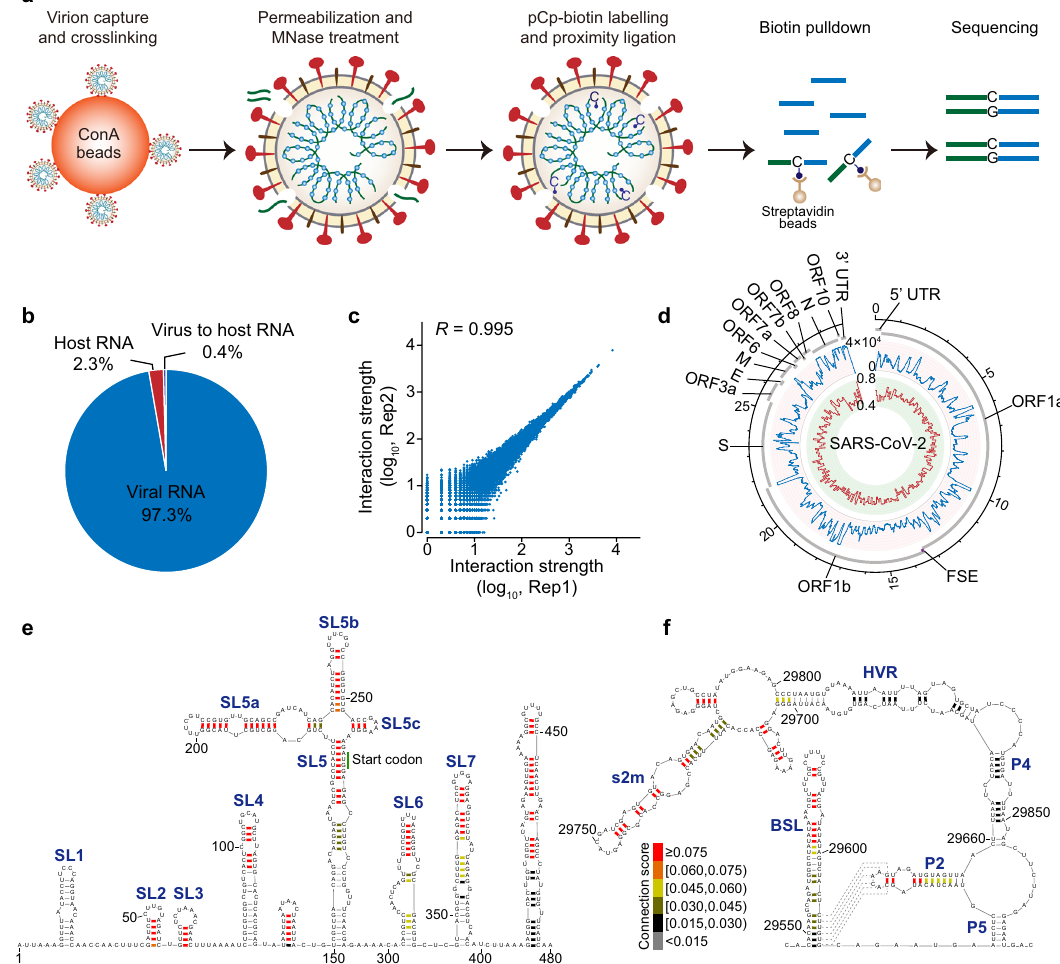
Fig. 1 Overview and evaluation of vRIC-seq technology. a Scheme of vRIC-seq technology. Concanavalin A (ConA) beads were used to capture the virion for diverse enzyme treatments in subsequent steps. b The proportions of chimeric reads mapped to SARS-CoV-2. c Scatter plots showing the correlation between two biological replicates for the number of chimeric reads (interaction strength). R , Pearson correlation coef fi cient. d Circos plot showing the distribution of chimeric reads along the SARS-CoV-2 genome. The inner red circle stands for the fractions of adenine or uracil within 100 nt windows, and the outer blue circle shows the coverage of chimeric reads. FSE frame-shifting element. e , f vRIC-seq con fi rmed known coronavirus RNA structures in the 5 ′ UTR (1 – 480 nt, e ) and 3 ′ UTR (29,546 – 29,870 nt, f ) of the SARS-CoV-2 RNA genome. Connection scores shown in different colors were used for assessing the base-pairing probability. The dashed lines illustrated the